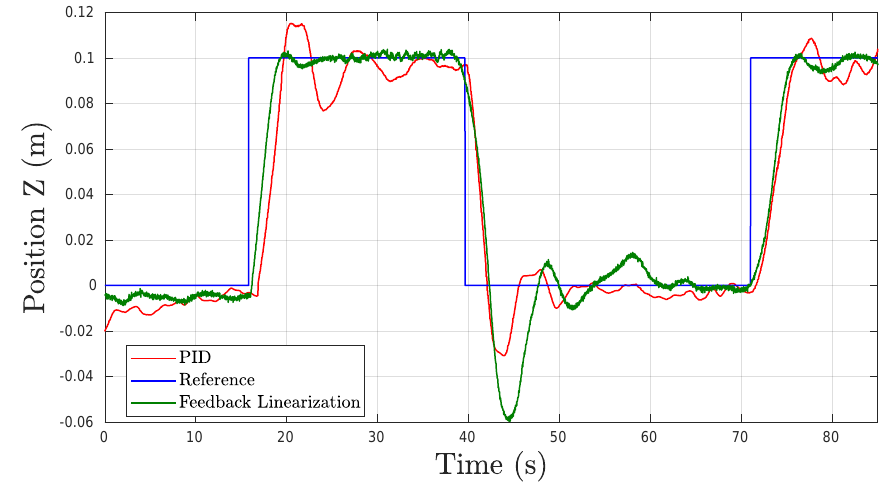
Figure 10. Experimental results obtained in underwater tests in Heave. Table 3. Heave Time Response Results in Underwater Experiments for PID and FL